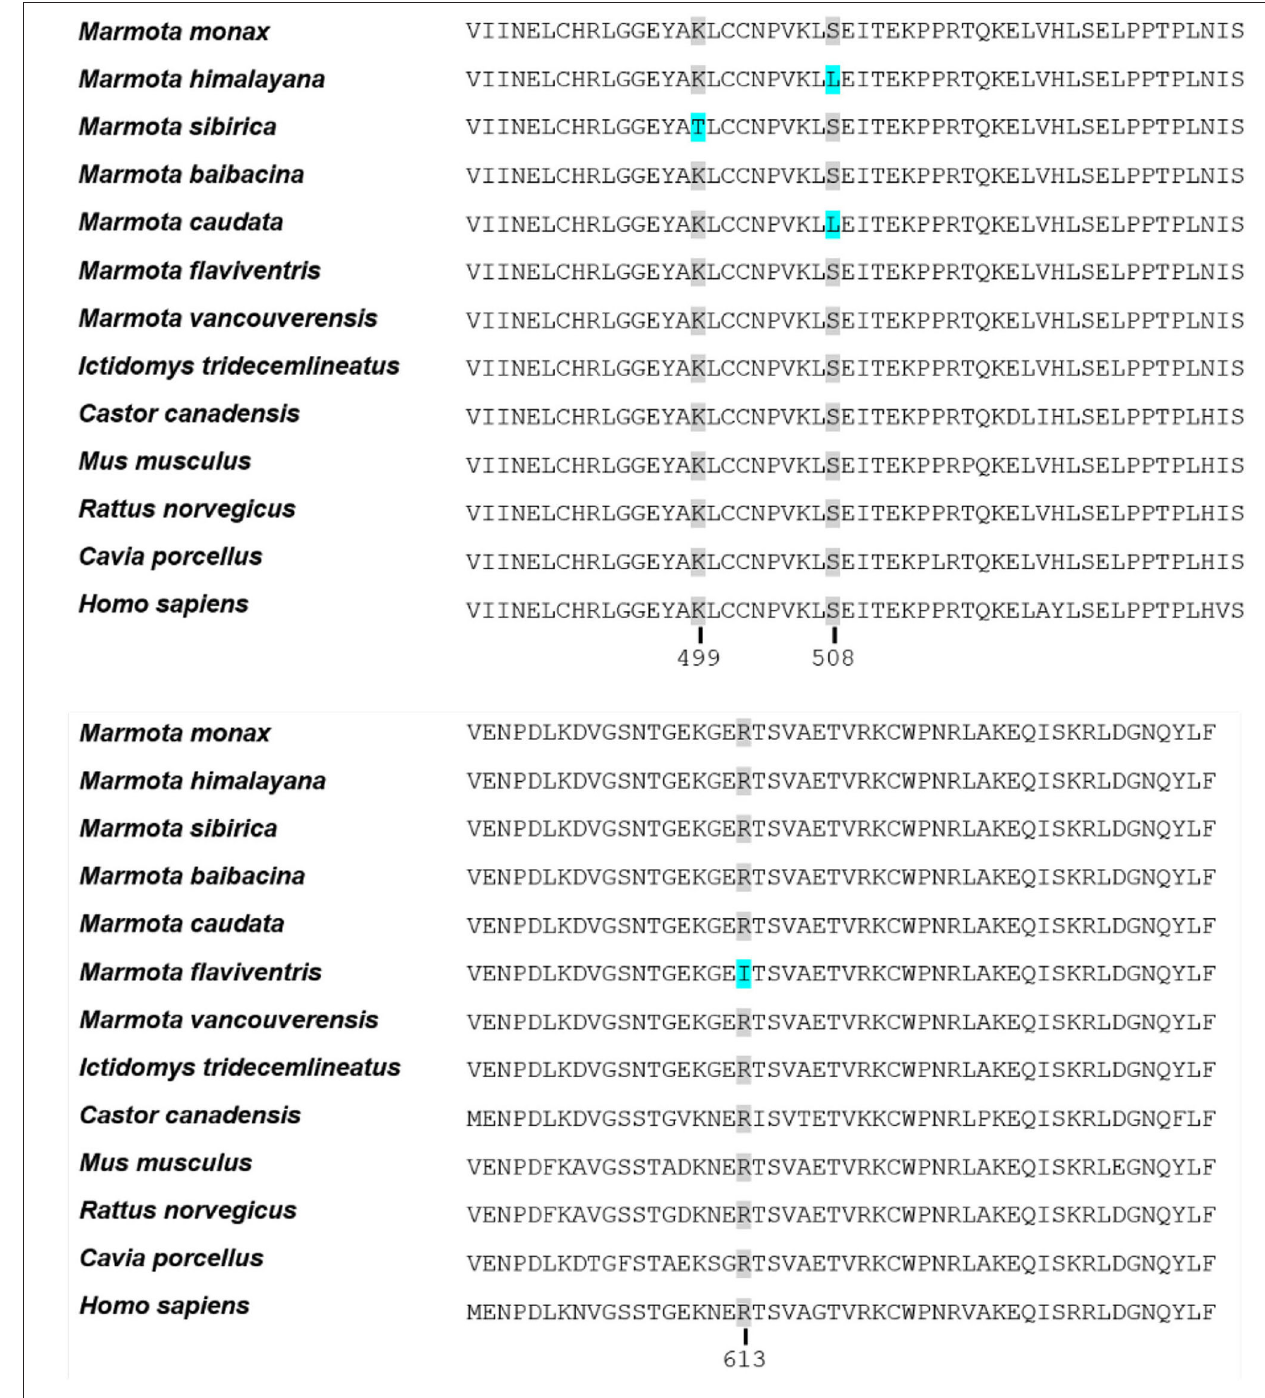
FIGURE 4 | Relevant sections of the alignment of SIRT1 proteins from 13 mammals including seven different marmots. Substitutions with the signature of positive selection (analyzed by branch site model comparison with codeml of the PAML package) are highlighted in blue (amino acid sites 499, 508, and 613). The Alignment was performed with